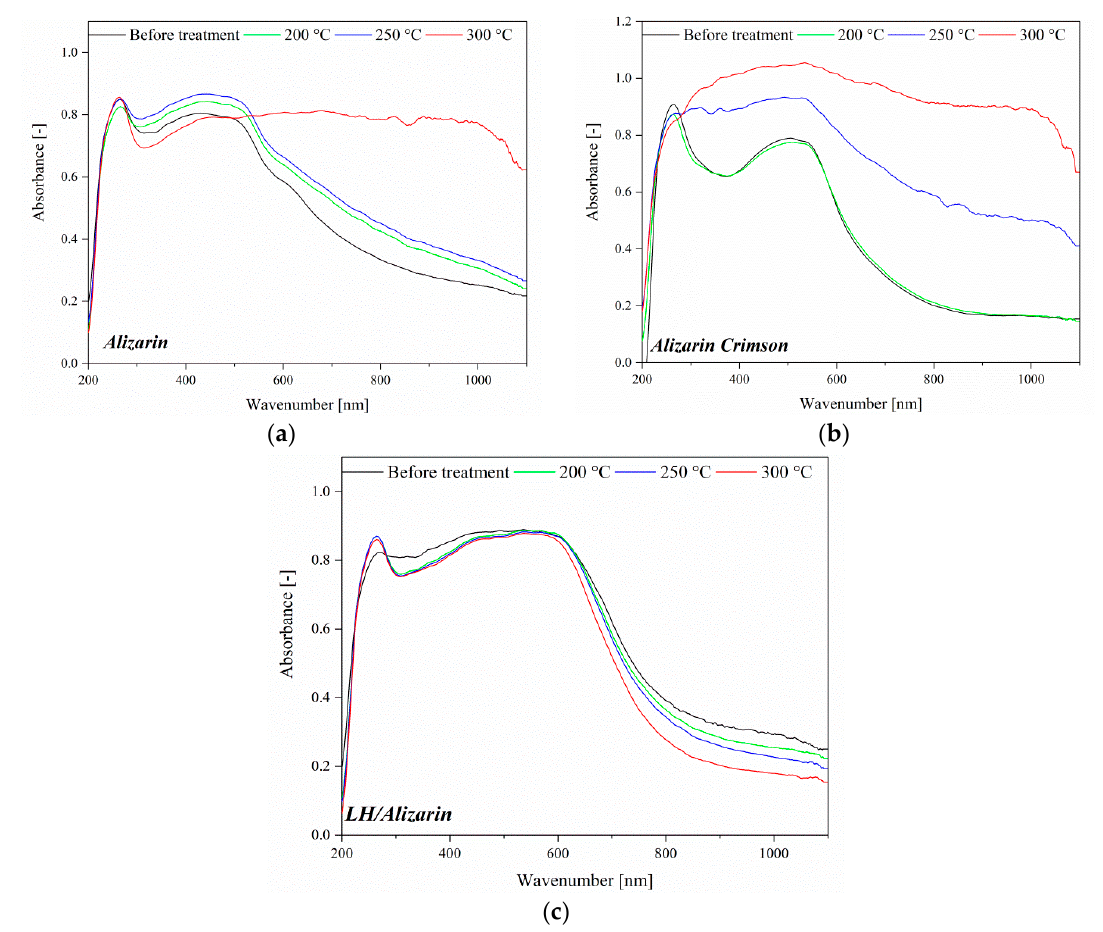
Figure 9. UV-VIS spectra of alizarin, Alizarin Crimson, and alizarin lake exposed to different temperatures: ( a ) alizarin; ( b ) Alizarin Crimson; ( c ) LH/Alizarin.